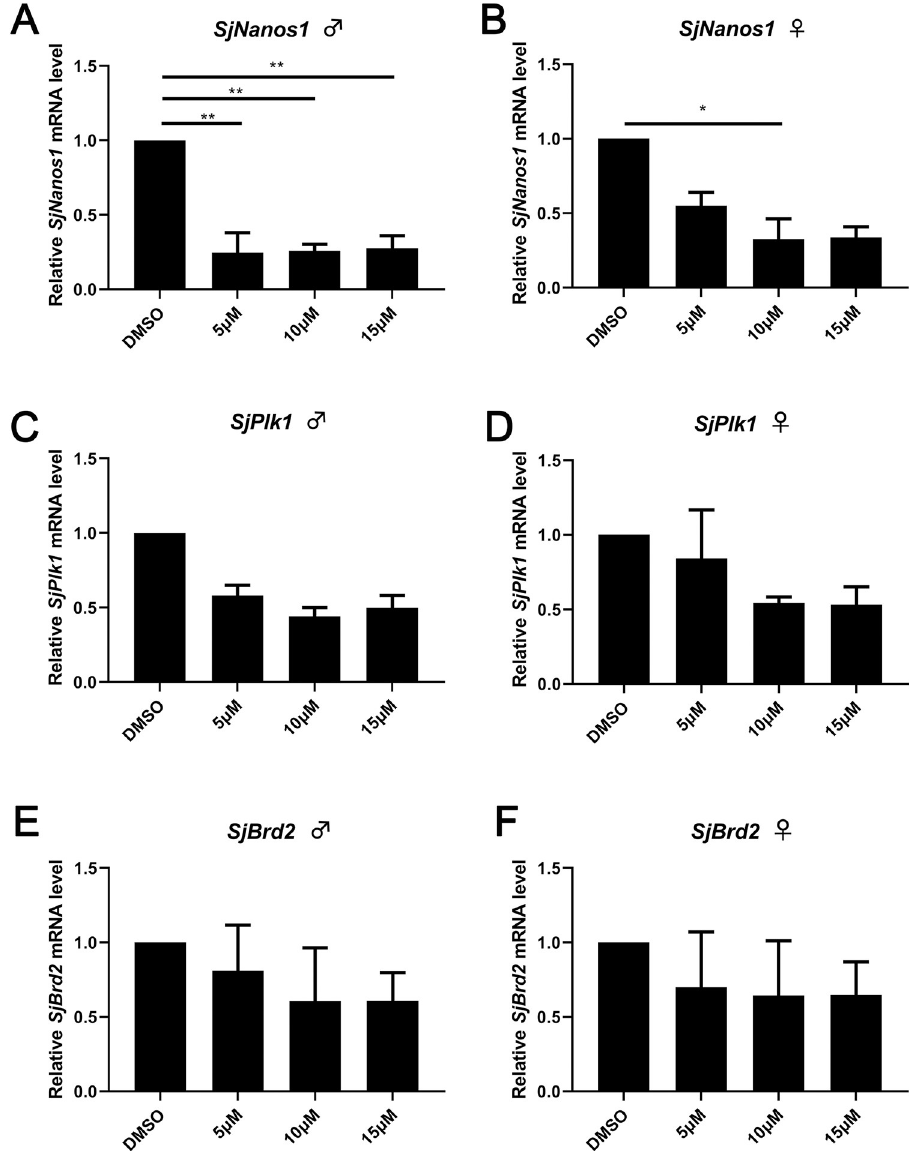
Fig 5. Results of quantitative PCR analyses of S . japonicum cultured with or without JQ-1 for 10 d. Relative transcription level of Nanos1 in male (A) and female S . japonicum (B). Relative transcription level of Plk1 in male (C) and female (D) S . japonicum . Relative transcription level of Brd2 in male (E) € and female (F) S . japonicum . Data represent the mean ± SEM of three independent experiments. Asterisks show statistical differences ( � P < 0.05; �� P < 0.01) tested by one-way ANOVA with multiple